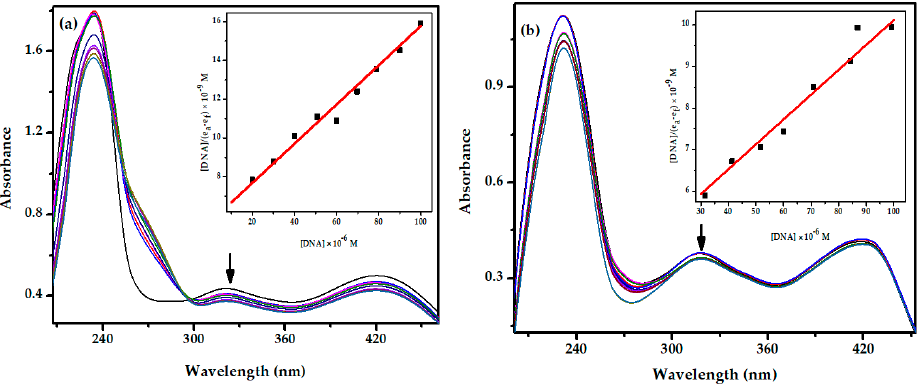
Figure 4. Absorption spectroscopic study of complex 1 ( a ) and 2 ( b ) (25 µ M) with increasing concentrations of CT–DNA (0–100 µ M). The inset shows the plots of [ DNA ]/( ε a – ε f ) versus [ DNA ] for the titration of the prepared compounds with CT–DNA.